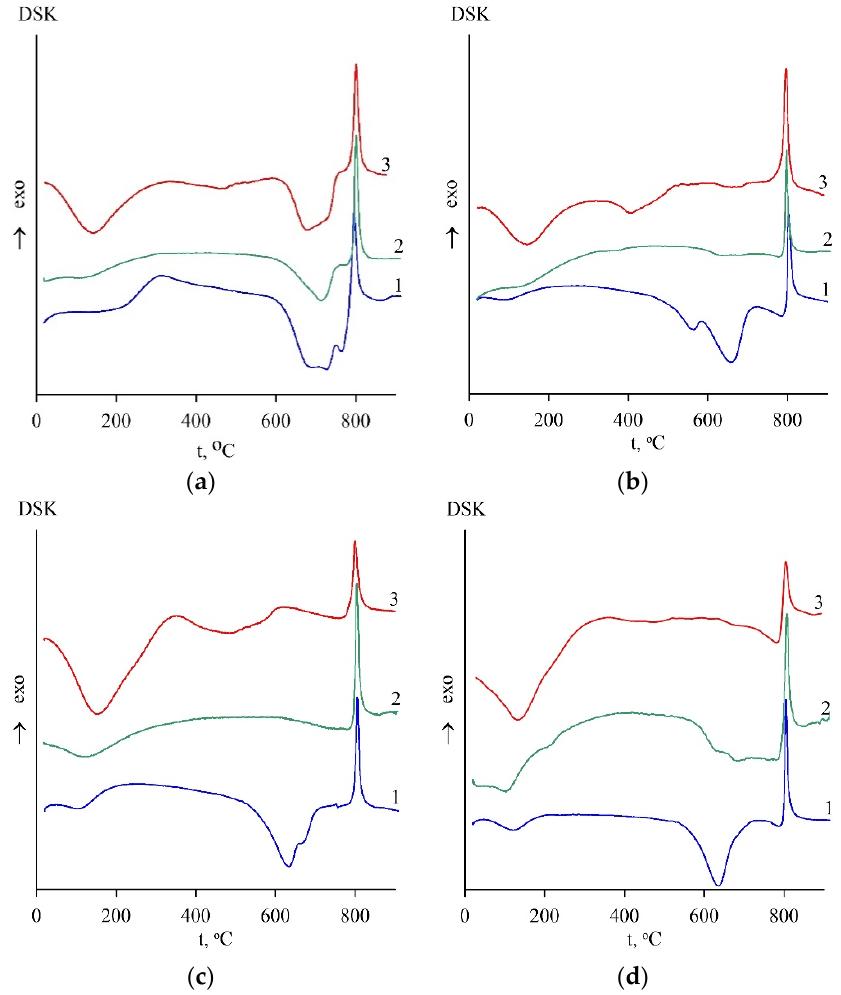
Figure 1. DSC results for serpentine samples: SAP ( a ), SCH ( b ), SLH ( c ), and SLK ( d ); curve for initial (1), heat ‐ treated (2), and hydrated heat ‐ treated (3) samples after 28 days of hardening.